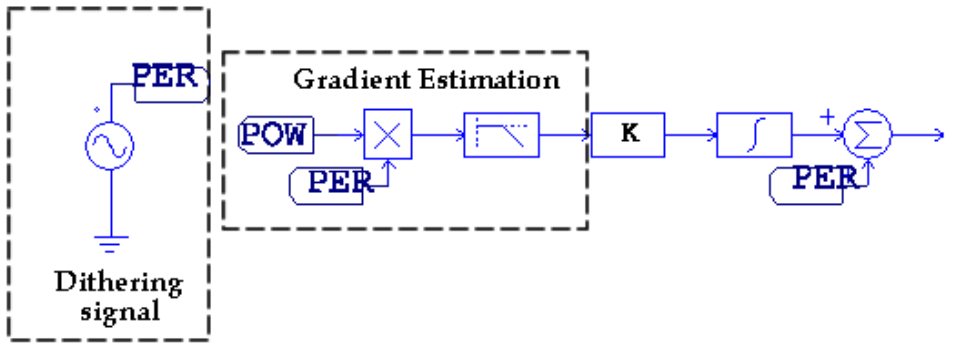
Figure 8. PSIM schematic of MPPT in ESC